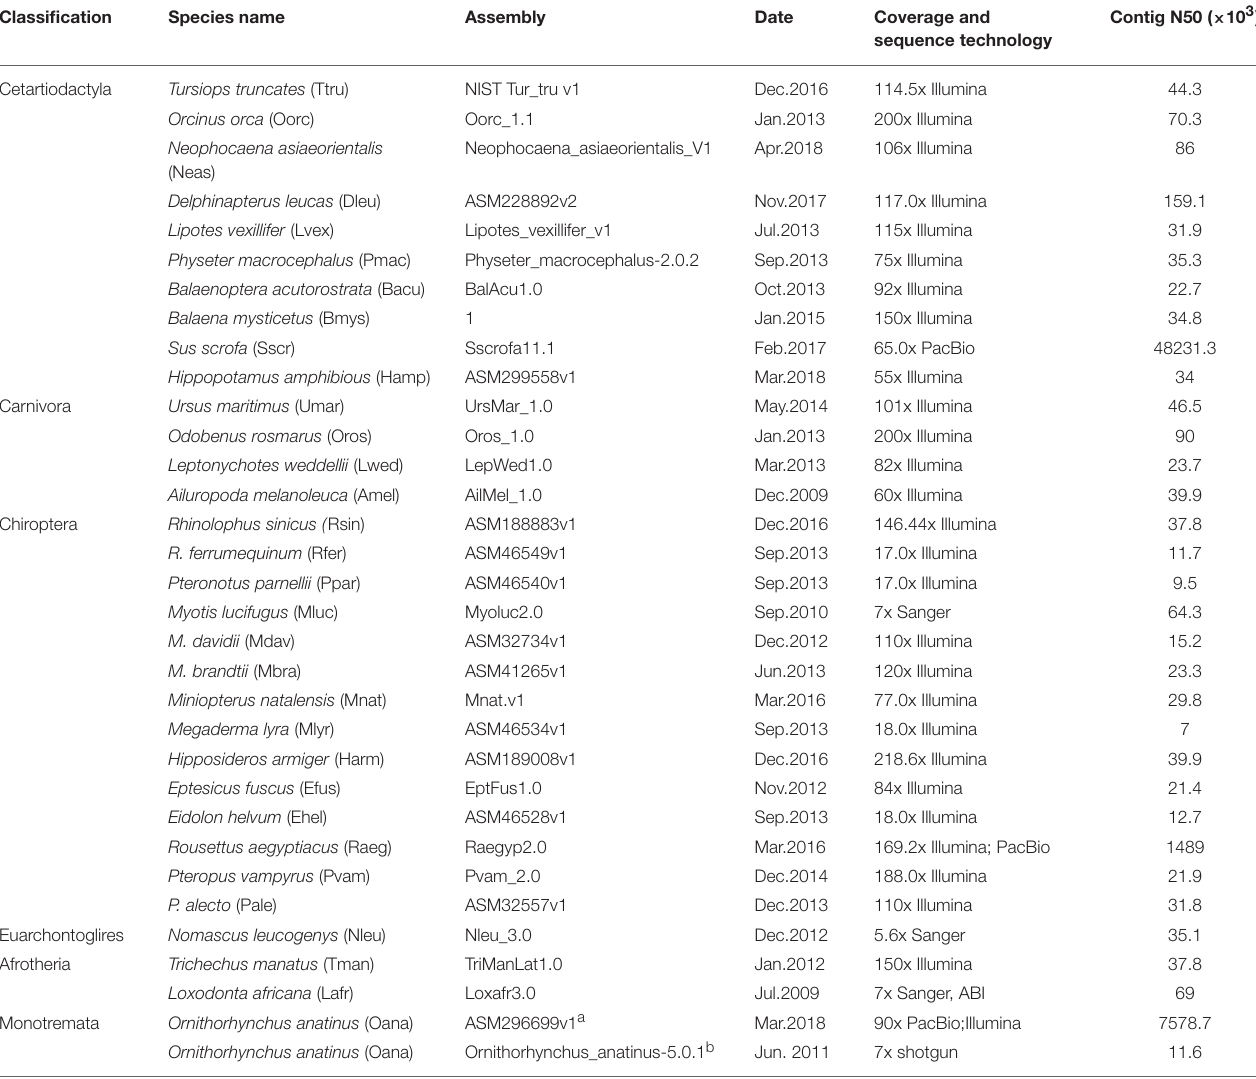
TABLE 1 | Genomic information of 32 mammal genomes used in this study.